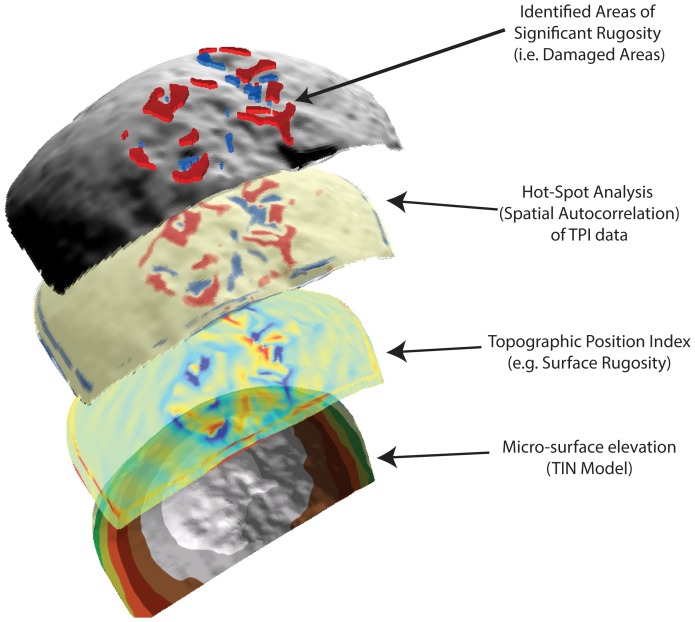
A schematic representation of the full analysis that identifies the statistically significant (spatially auto-correlated) areas of percussive damage.The three dimensional nature of this representation prohibits the use of a scale, however this is the specimen that is represented in Figure 2 and as such provides an estimate of the overall size of the damaged area.